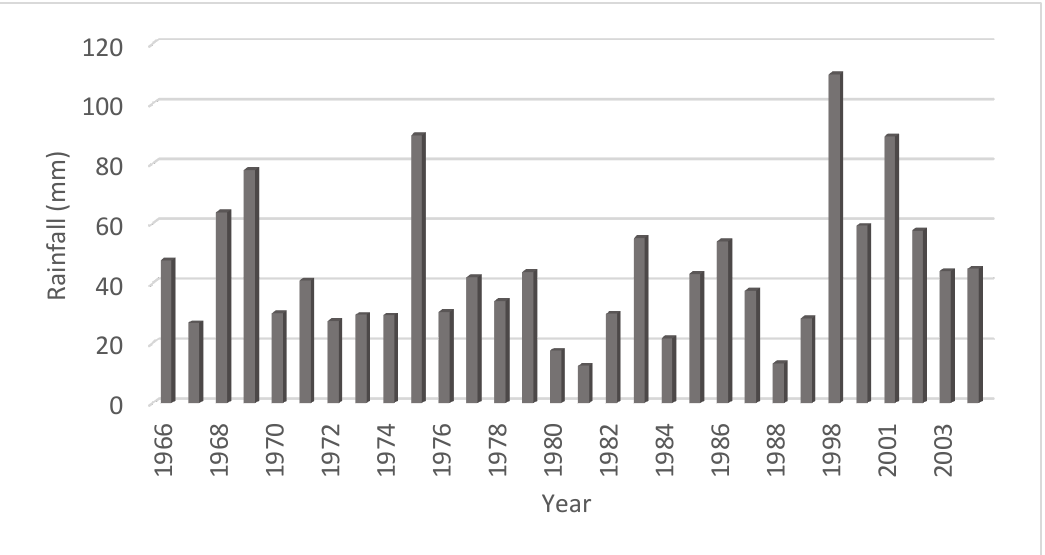
Figure 2. Maximum 24 h rainfall precipitation at J-204 station. Table 2. Statistical characteristics of the annual maximum daily rainfall of J-204 station.